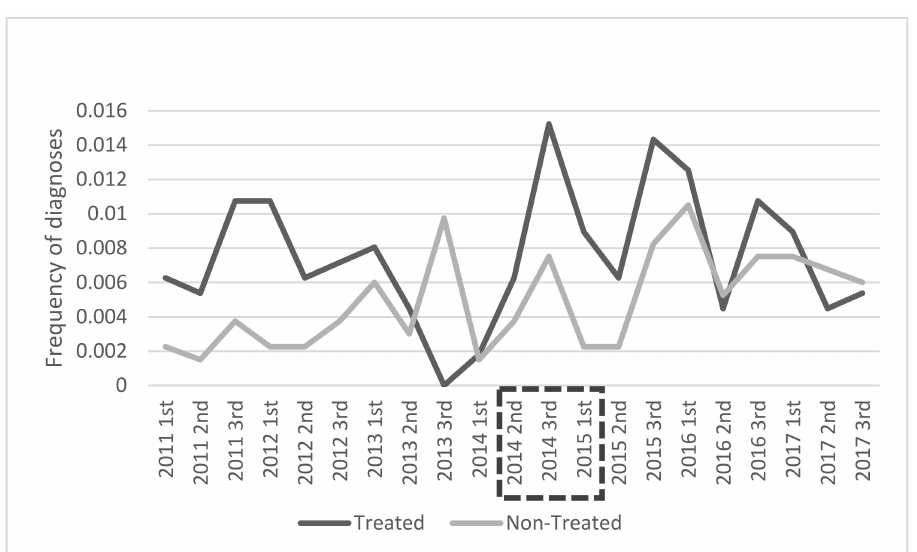
Figure A3. Time-trend frequency of severe asthma diagnoses compared by group; The circled area indicates the intervention period.